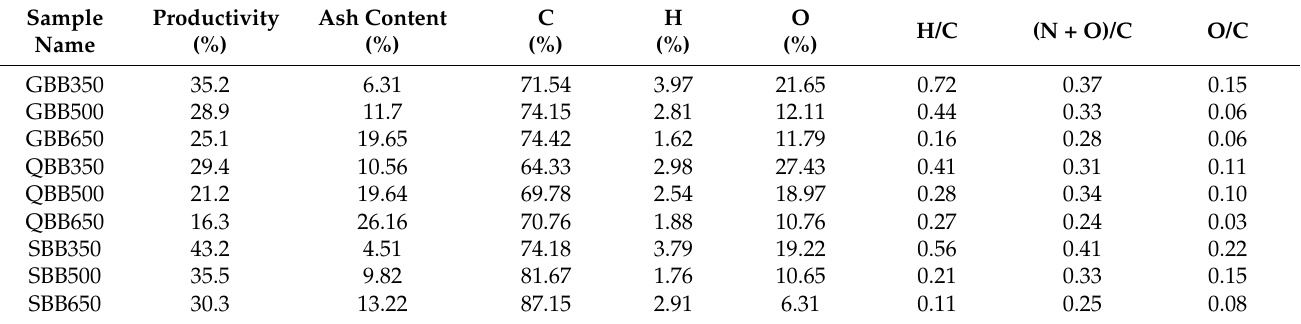
Table 1. Elemental composition, ash content, and yield of biochar prepared at different